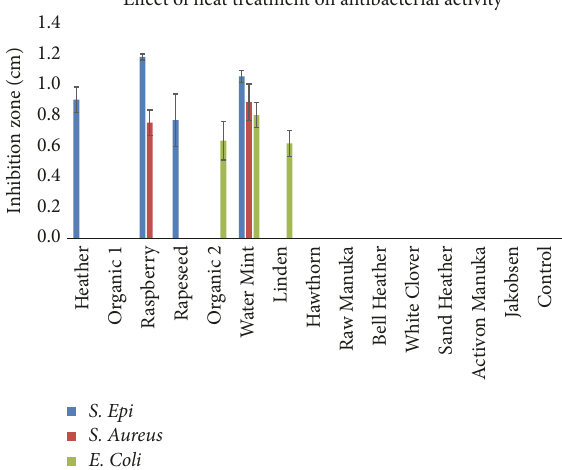
Figure4:Antimicrobialeffectofhoneysamplesafterheattreatment at 60 ∘ C/30min. Some samples still showed antibacterial activity. These samples include Heather, Raspberry, Rapeseed, Organic 2, Water Mint, and Linden (mean ± SD; n =